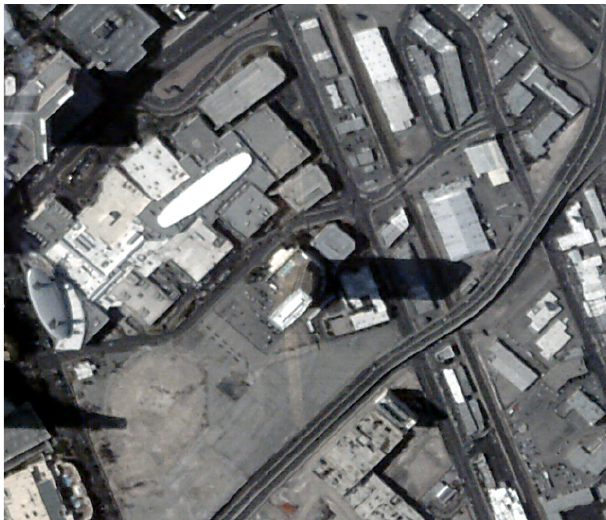
Figure 4. HRC Image of the Trump Tower in Las Vegas, Nevada